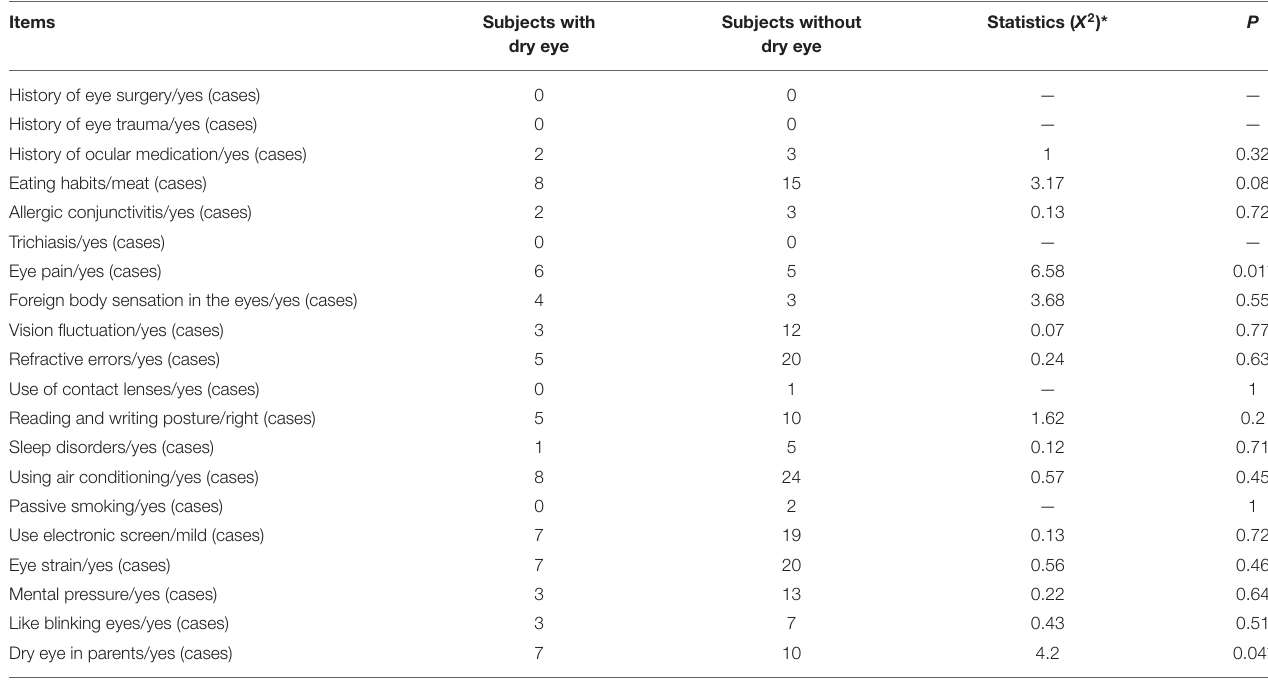
TABLE 2 | The questionnaire information of 40 children with